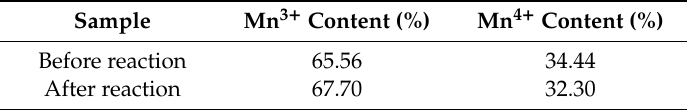
Table 2. Analysis of Mn value in Co-OMS-2 before and after